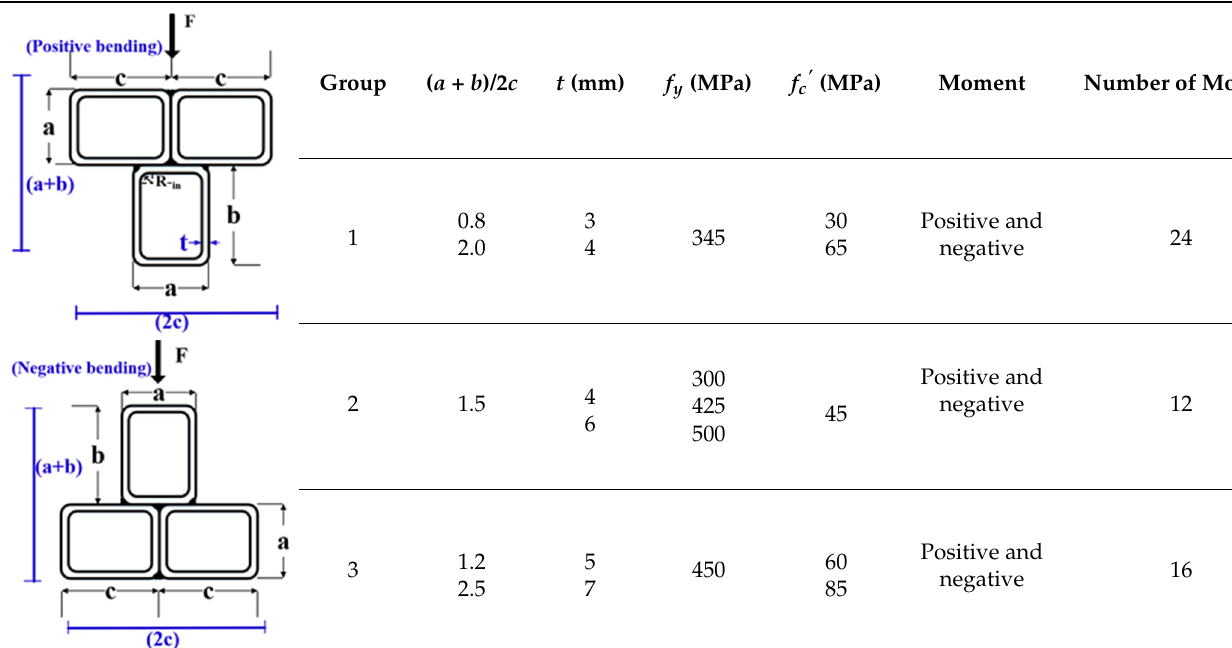
Table 4. A summary of the FE models used for verification.